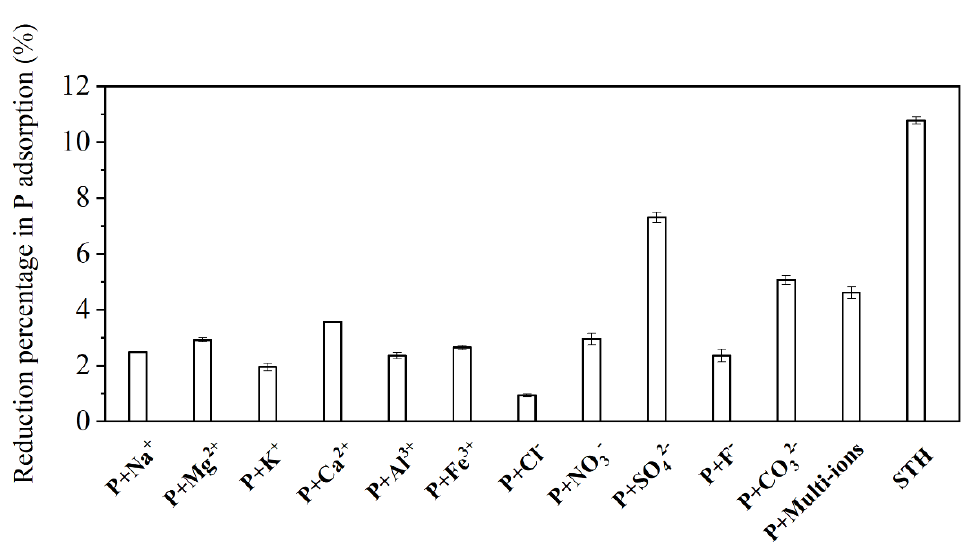
Figure 4. Effect of coexisting ions on the reduction of phosphate adsorption amount.